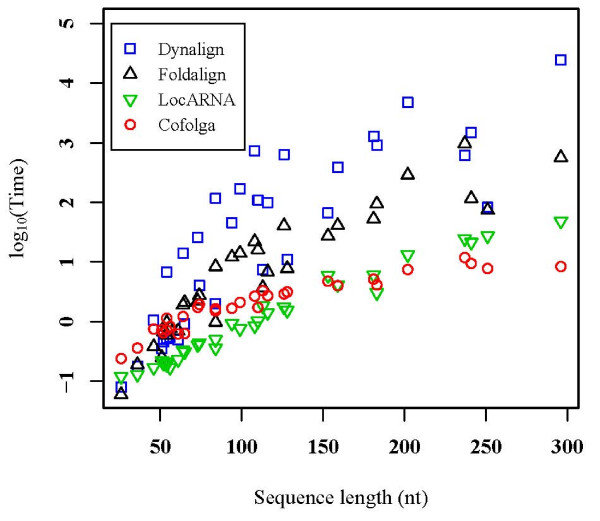
Comparison of computational times. Each symbol corresponds to the averaged computational time and averaged sequence length of one RNA family, where time is represented as log10(time in seconds).